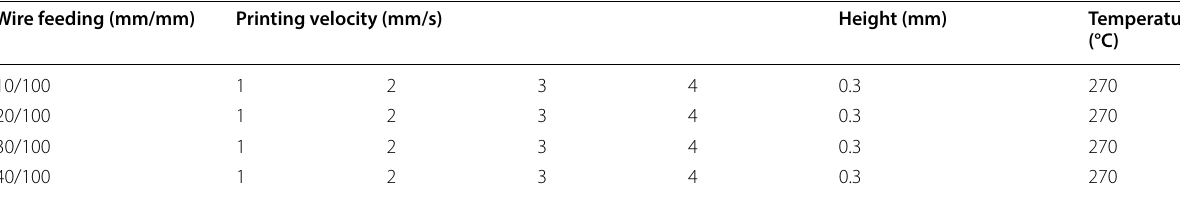
Table 2 The printing parameters of monofilament specimens Wire feeding